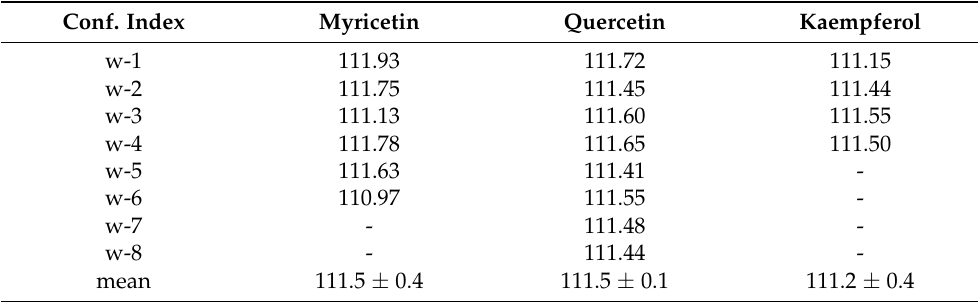
Table 6. The calculated IEs for each conformer and the means and standard deviations of the IEs for each molecule